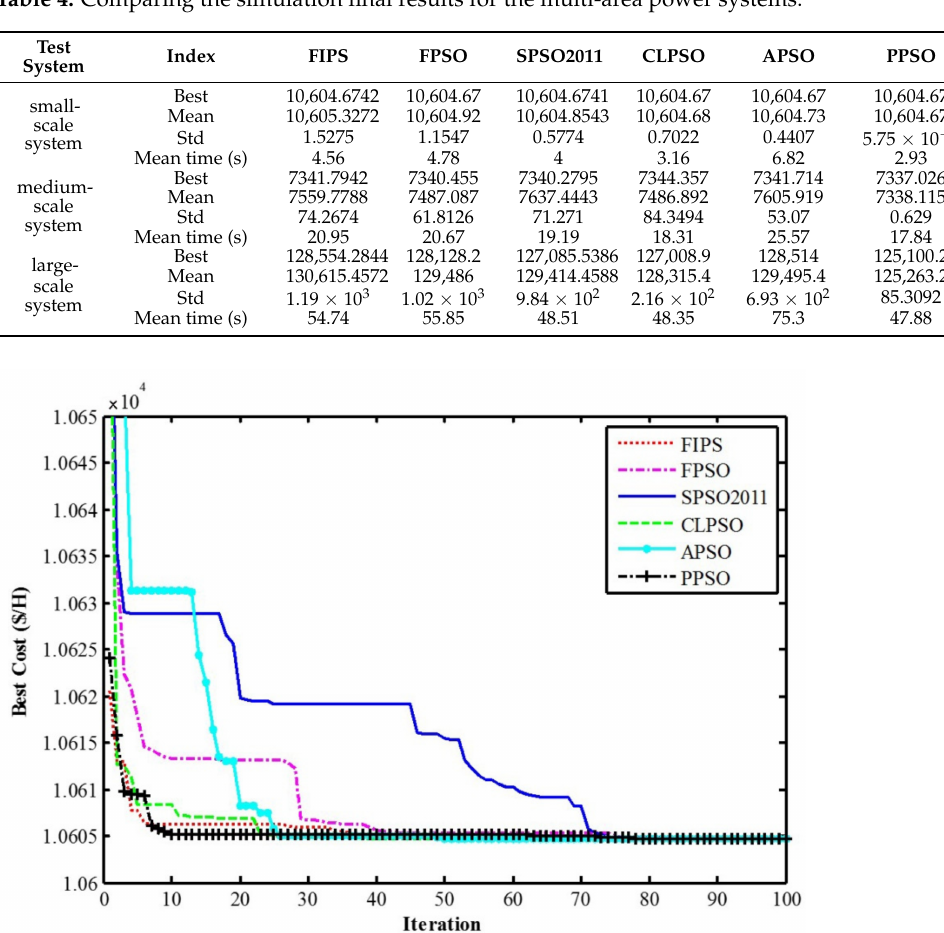
Figure 3. Convergence graphs of different PSO algorithms for the small-scale test